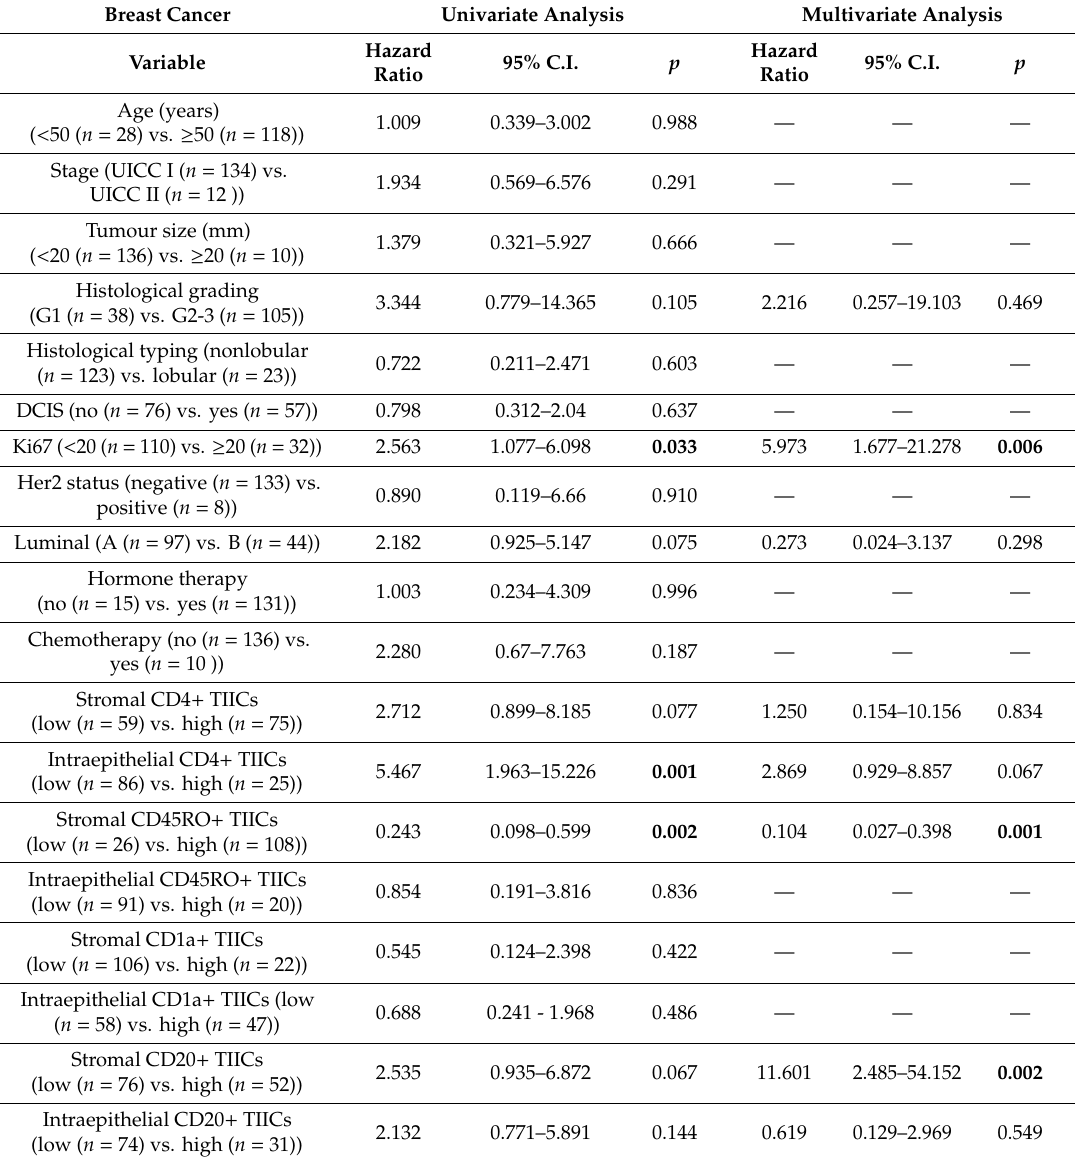
Table 4. Univariate and multivariate analysis of disease-free survival according to Cox’s proportional hazards model. Breast Cancer Univariate Analysis Multivariate Analysis